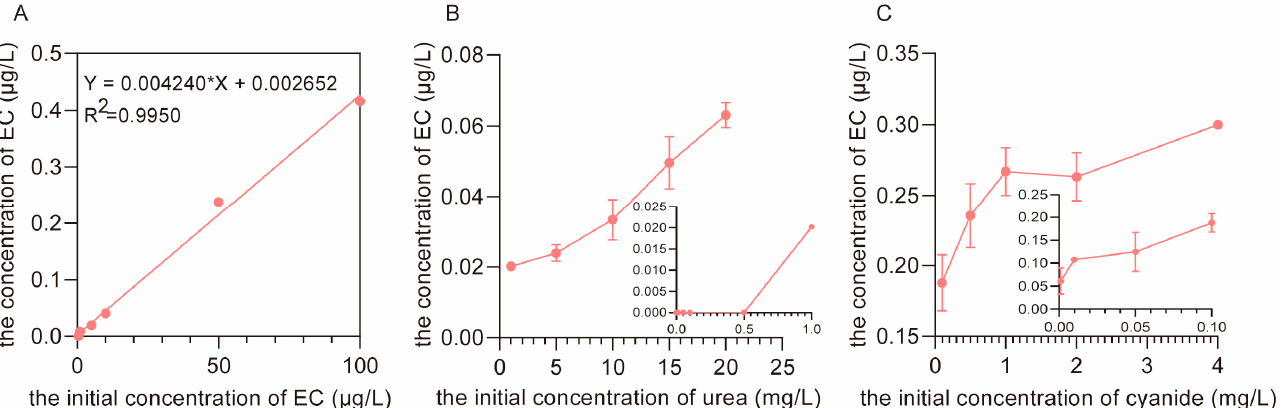
Figure 7. The concentration of EC in the distillate after 10 min of distillation at 100 °C. ( A ) Co-distillation of ethanol with different concentrations of EC. ( B ) Co-distillation of ethanol with different concentrations of urea. ( C ) Co-distillation of ethanol with different concentrations of cyanide.